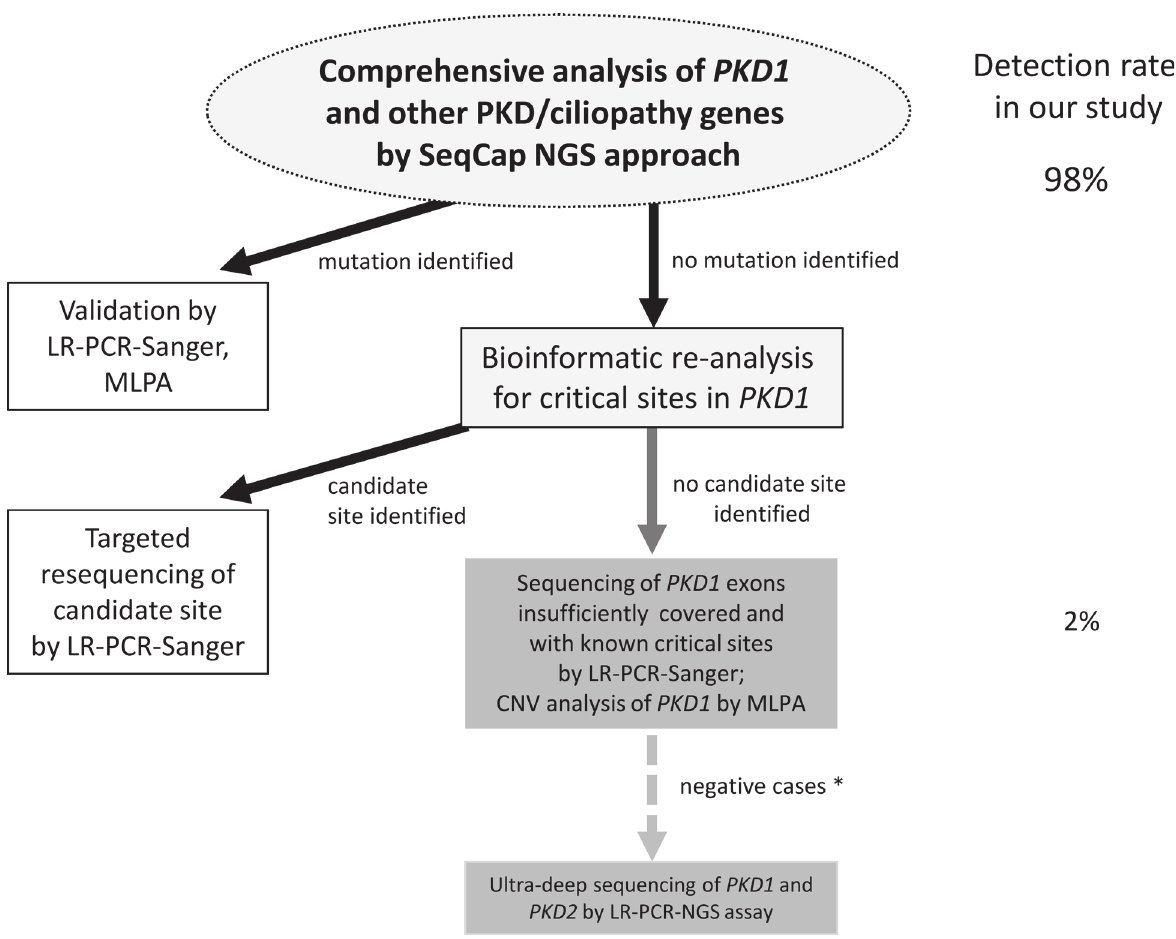
Fig 5. Comprehensive and complete testing strategy for ADPKD diagnostics. Sequence capture based NGS for variant detection in PKD1 and all other targeted ciliopathy genes at standard filter criteria is the central and first step in the analysis which includes validation of putative mutations by conventional techniques (LR-PCR-Sanger, MLPA). By this, in more than 98% of our cohort the disease-causing mutation could already be identified. Further optional steps to minimize the risk of false negative results include deeper bioinformatic analysis of acquired NGS data and restricted use of conventional methods. Bioinformatic re-analysis by lowering the detection threshold ( > 8% alternative reads) in mutation-negative samples might provide candidate sites in PKD1 where concurrent mapping of reads between the genuine gene and homologous regions impairs proper variant detection. Candidate sites are validated by conventional Sanger sequencing. If still no convincing mutation is present, restricted sequencing by LR-PCR-Sanger of insufficiently covered regions (exon 1) as well as those exons with empirically evaluated critical regions bearing mapping difficulties (in our study exons 5, 11, 17, 21, 26) is the next option and would have generated the correct result for patient 21 of our study. In parallel, MLPA analysis of PKD1 can be used to rule out false-negative CNV results. An optional final step might be ultra-deep sequencing with very high coverage of the PKD1 and PKD2 coding sequence (S9 Table) especially in those